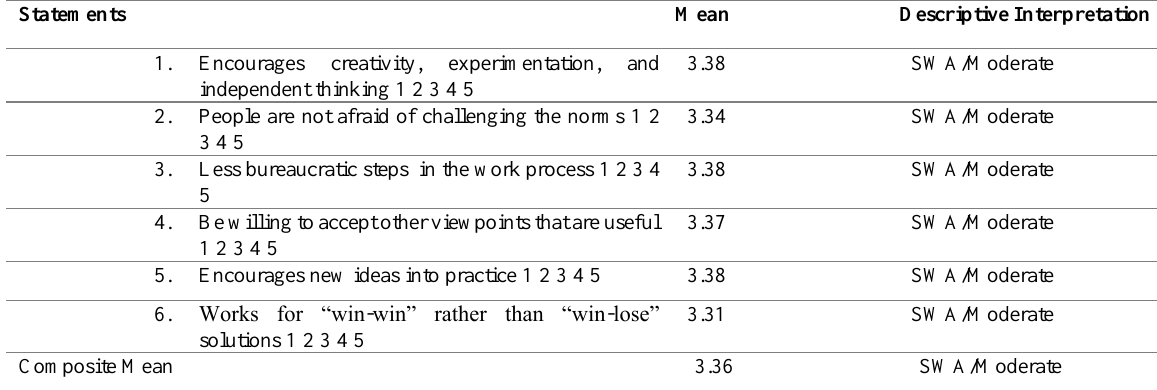
Table 4: Organizational Climate Along with Flexibility